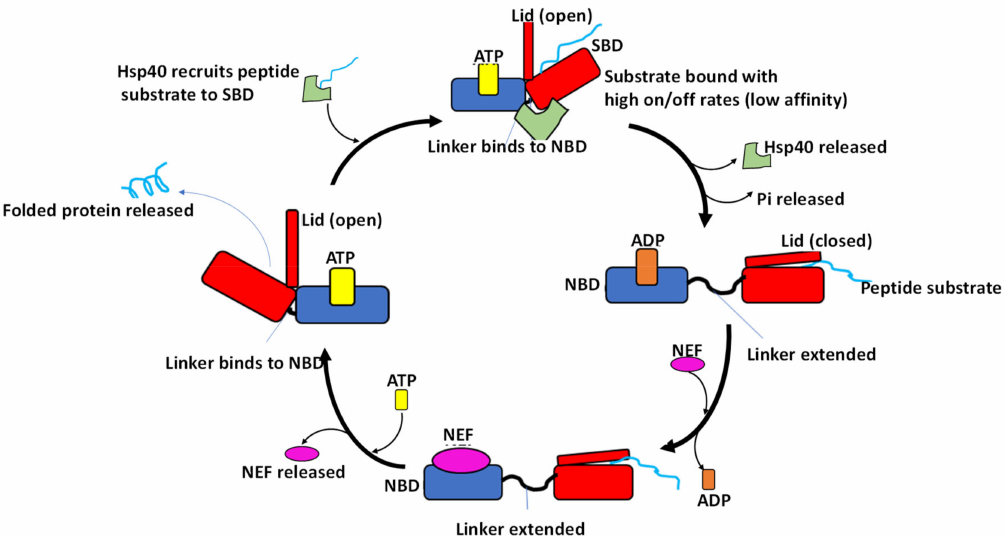
Figure 4. Hsp70 functional cycle. The Hsp40 coupled-protein substrate is delivered to the SBD of the ATP-bound Hsp70. ATP is hydrolyzed and Hsp40 is released from the chaperone complex. Upon Hsp70 binding to ADP, its lid closes to tightly clamp the substrate within the SBD. A nucleotide exchange factor (NEF) facilitates the exchange of ADP for ATP. In the Hsp70-ATP conformation, the lid is open, and the chaperone possesses lower a ffi nity for peptide. This results in the release of the peptide substrate from Hsp70. The fully folded protein is subsequently released. Figure adapted from